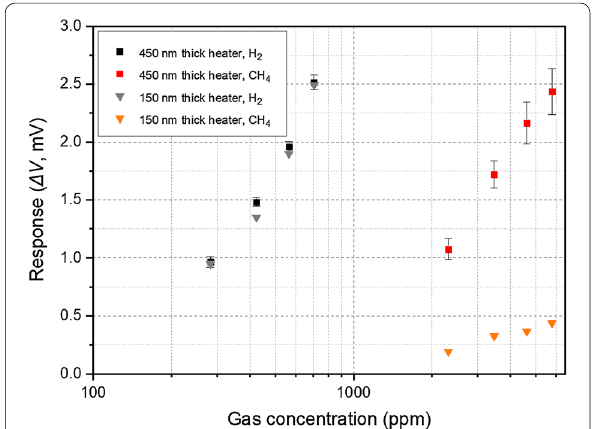
Fig. 4 Response vs. gas concentration of the fabricated catalytic combustible type single‑chip micro gas